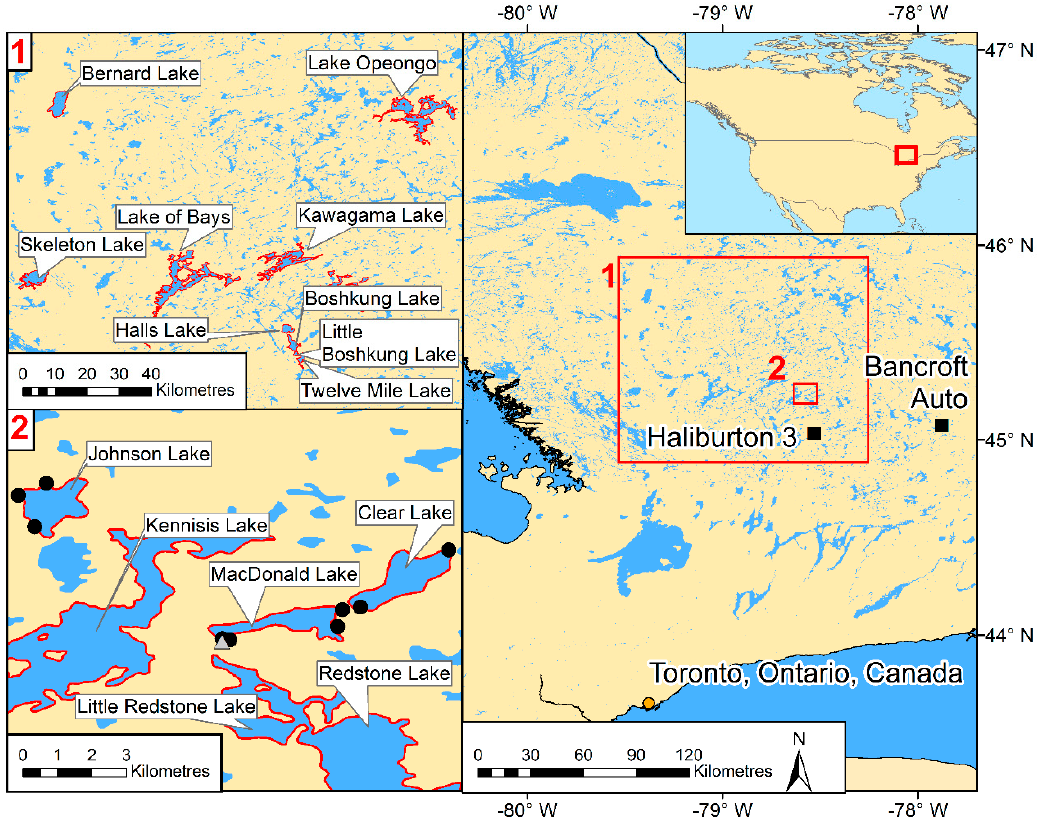
Figure 1. Study region lakes across Ontario. The black boxes on the map indicate the location of the weather stations used to supplement in situ climate data. Study lakes are highlighted in red. Panel 1 shows the 15 study lakes in Central Ontario. Panel 2 shows the three primary study lakes in the Haliburton Forest and Wildlife Reserve Ltd. (MacDonald, Clear, and Johnson Lakes), other lakes of interest in the Haliburton area, the location of the MacDonald Lake weather tower (grey triangle), and shoreline cameras (black dots).